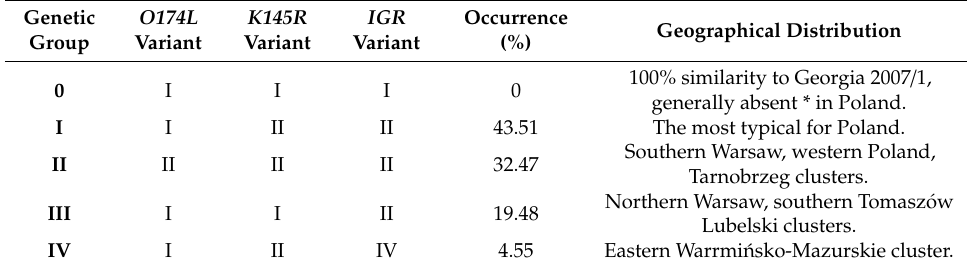
Table 2. Genetic variants distinguished in Poland based on concatenated sequences of K145R , O174L and IGR I73R/I329L .